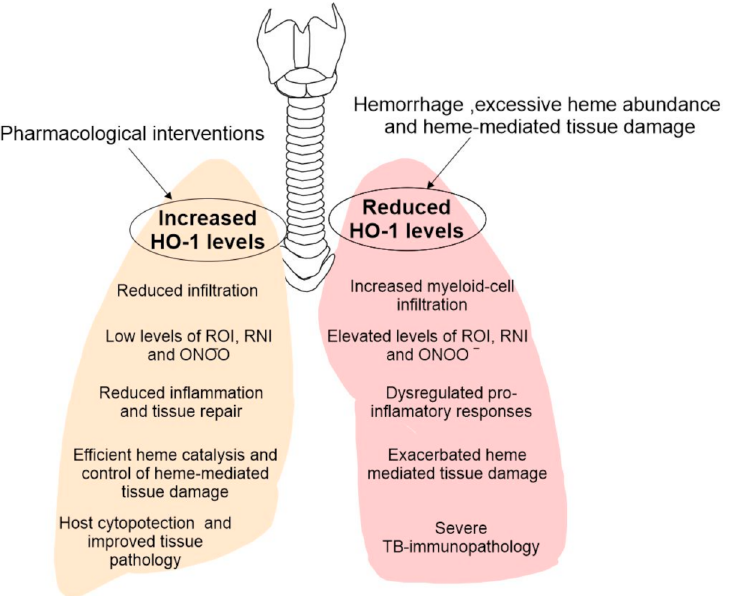
Figure 3. Model for the impact of HO-1 levels in the outcome of TB immunopathology. During late stages of TB disease, there is a significant hemorrhage and heme release in the surroundings of disease which causes reduction in HO-1 levels and its enzymatic activity. Heme, a very potent oxidant molecule, causes significant tissue damage. This is accompanied by uncontrolled infiltration of myeloid cells and their pro-inflammatory functions, causing significantly elevated levels of ROI, RNI and ONOO − and exaggerate the TB immunopathology. Conversely, using HO-1 as HDT target and inducing its levels, especially during late stages of TB could provide host cytoprotection by improving heme catalysis, decreasing immune cell infiltration and supporting anti-inflammation and tissue